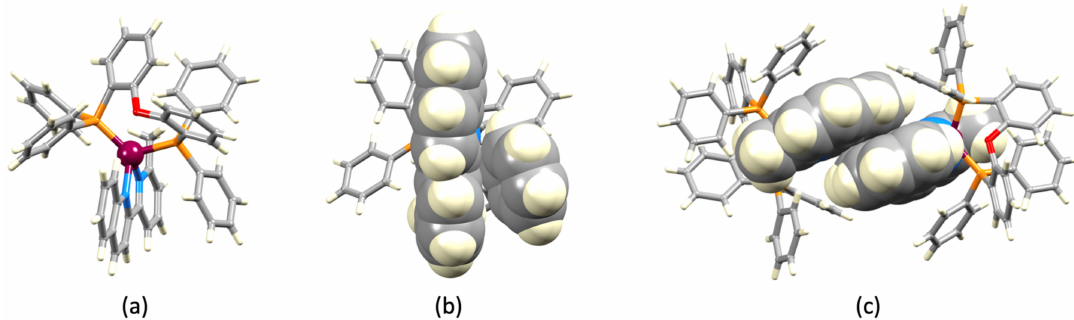
Figure 8. ( a ) and ( b ) Each [Cu(POP)( 2 )] + cation o ff ers only one, non-optimal π -stacking interaction. ( c ) Pairs of cations engage in a centrosymmetric π -stacking embrace.